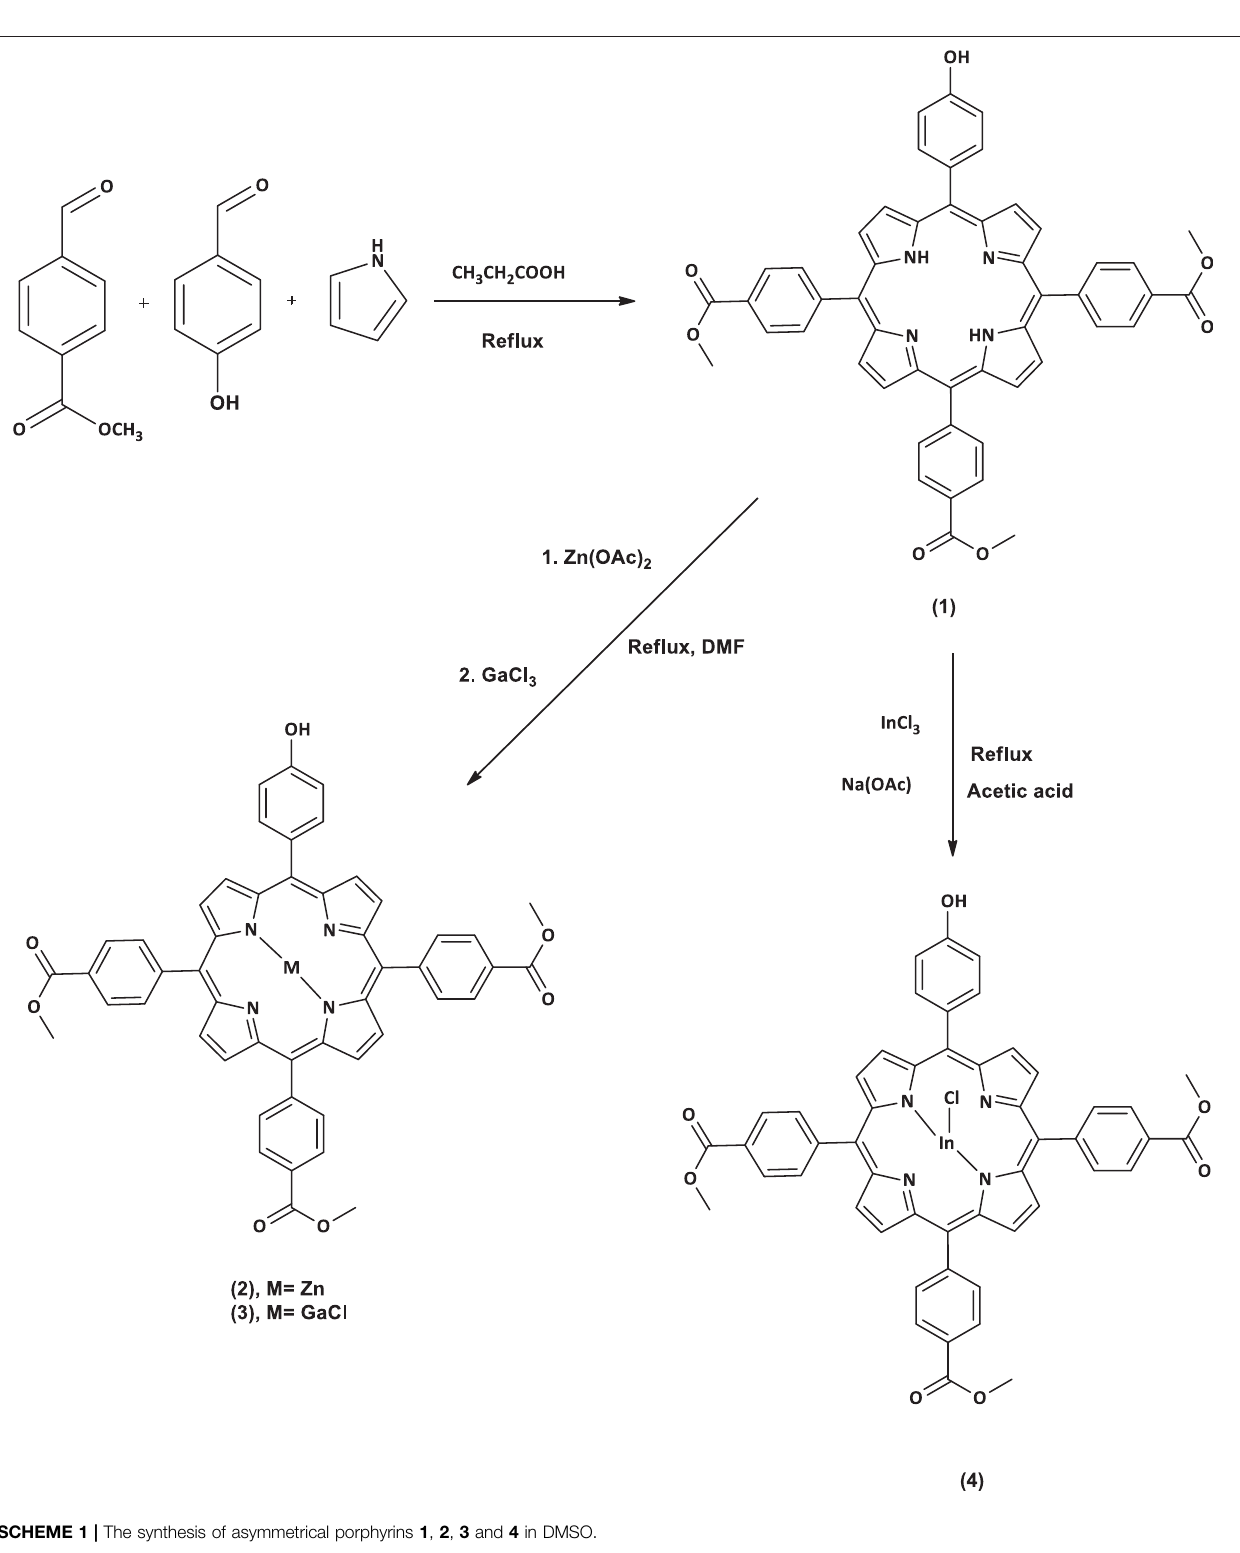
Frontiers in Chemistry |